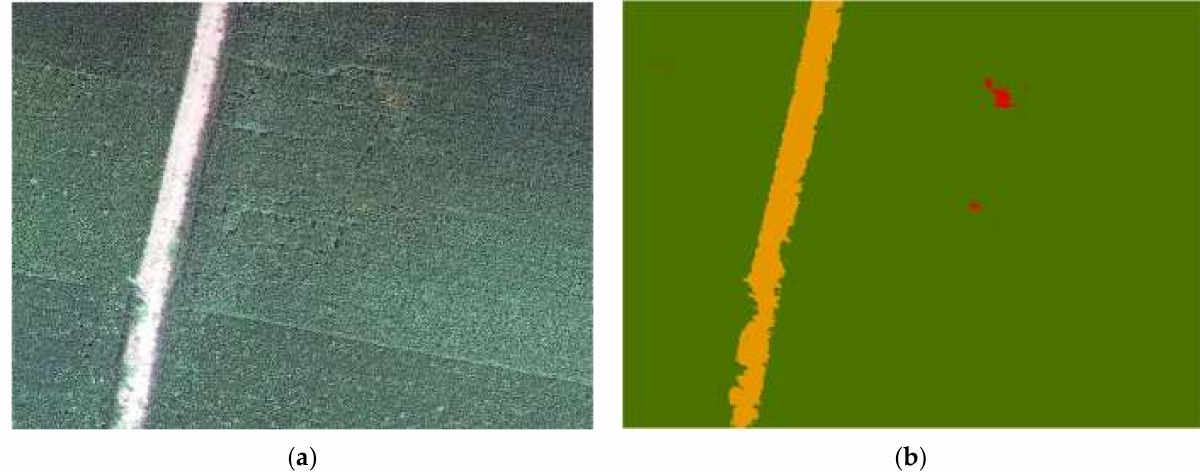
Figure 7. The predicted output of the original image and the PSPNet model. ( a ) is the original figure, and ( b ) is the predicted output result of the